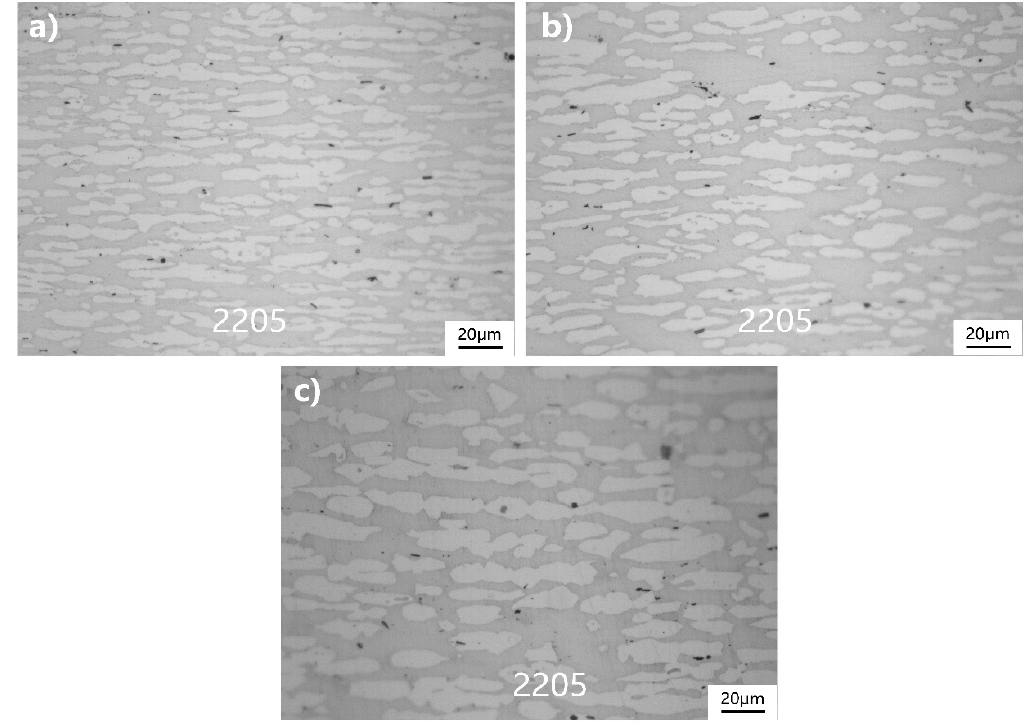
Figure 11. Ferrite distribution on the surface of 2205 duplex stainless-steel: ( a ) 1100 °C, ( b ) 1150 °C, and ( c ) 1200 °C.